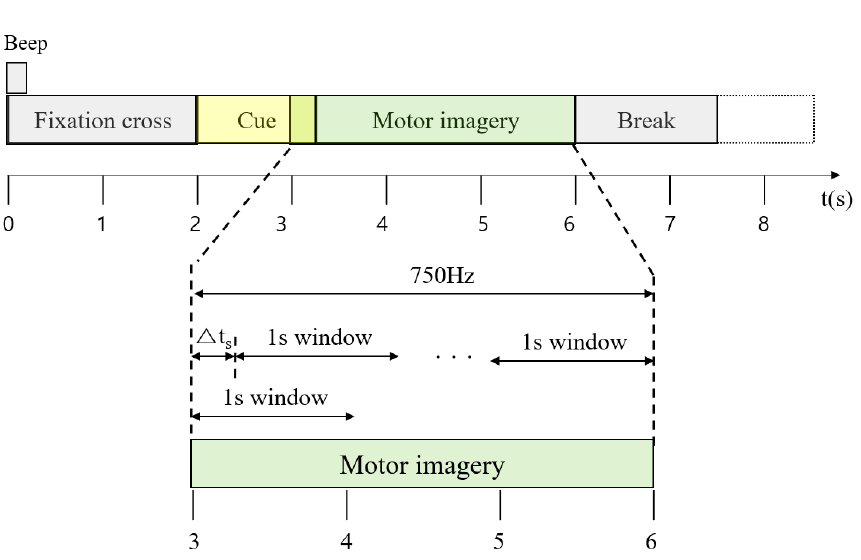
Figure 1. Feature extraction from a single-trial EEG.